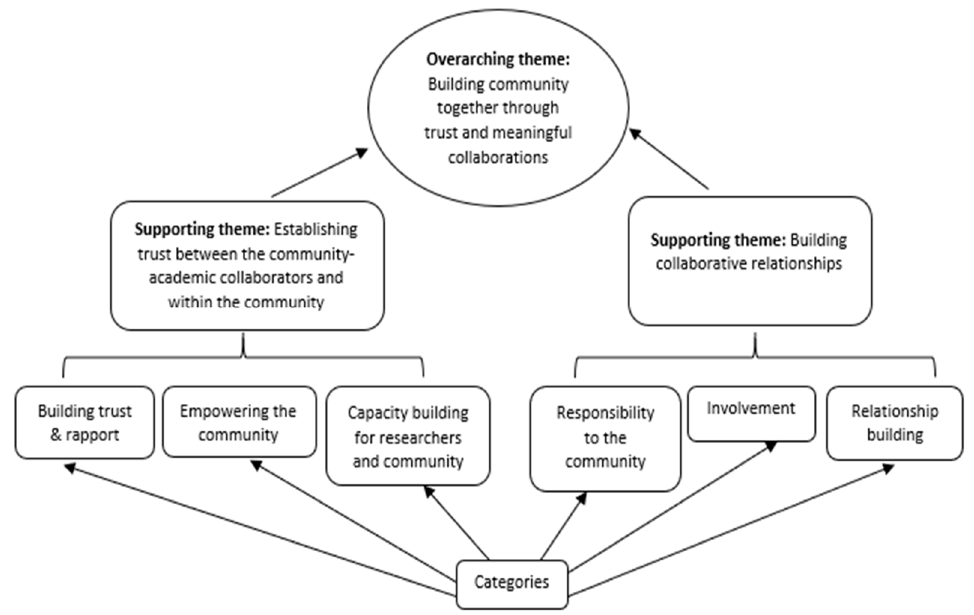
Figure 2. Categories, Supporting Themes and Overarching Theme.